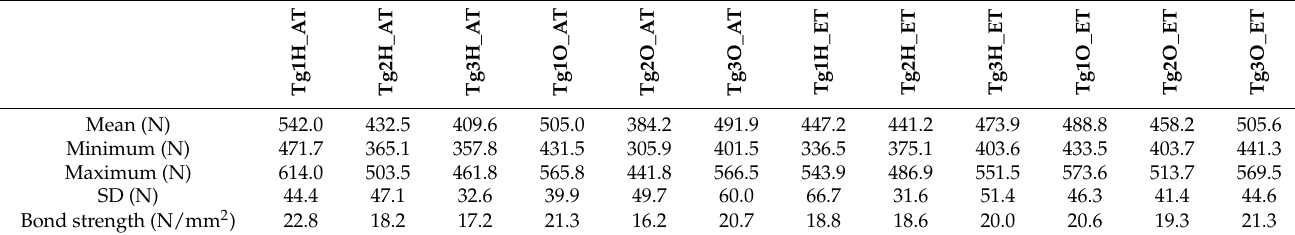
Figure 10. Pulling test results: ( a ) at ambient temperature; ( b ) at elevated temperature (100 °C). Table 3. Summary of the measured and calculated